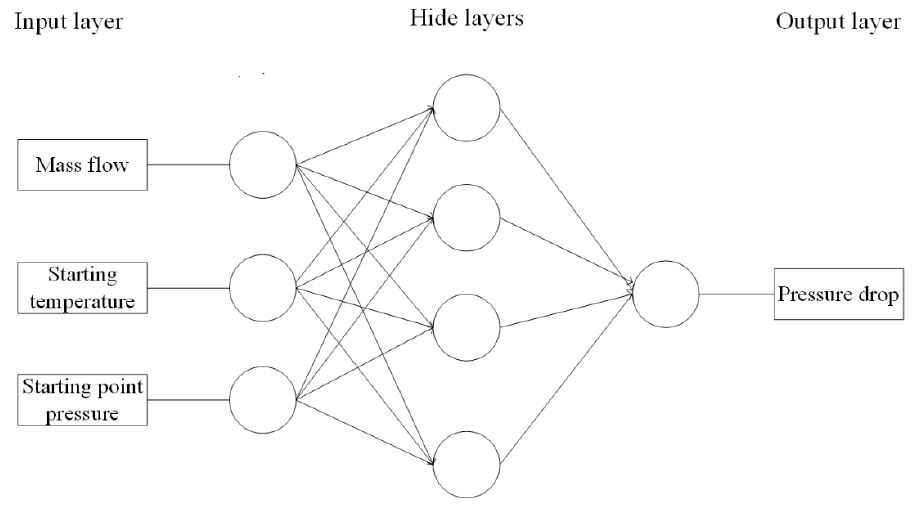
Figure 3. Pressure drop model of traditional BP neural network.